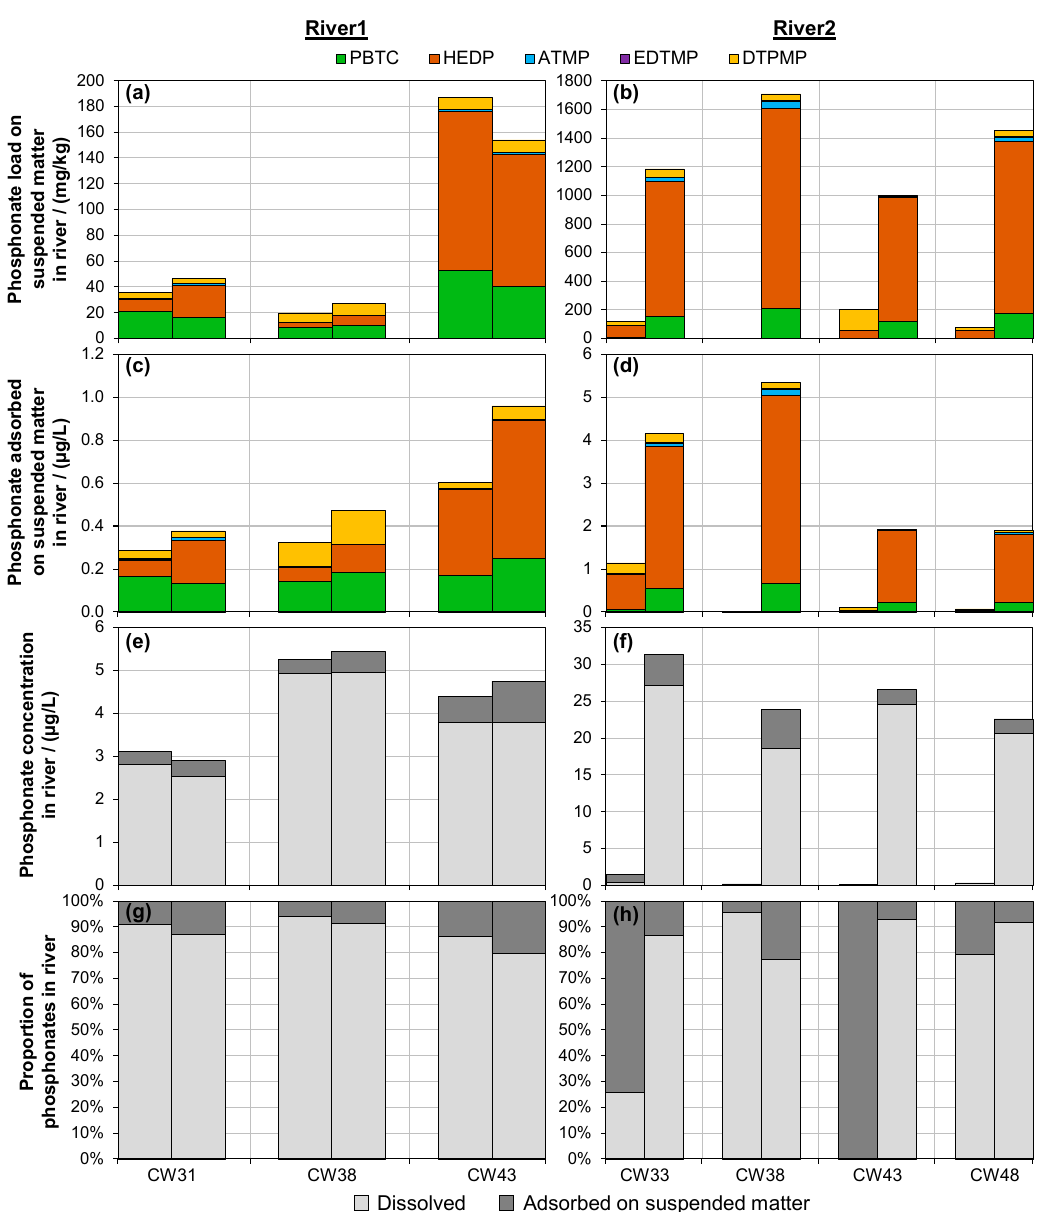
Figure 8. Phosphonate content on suspended matter (SM) in the two investigated rivers before ( left columns ) and behind the WWD ( right columns ) in each calendar week. Single analytes ( a – d ), total phosphonate ( e – h ), phoshonate load on SM ( a , b ), phosphonate content of the river water with respect to adsorbed phosphonate on SM ( c , d ), absolute phosphonate content of river water: dissolved vs. adsorbed on SM ( e , f ), and relative phosphonate content of river water: dissolved vs. adsorbed on SM ( g , h